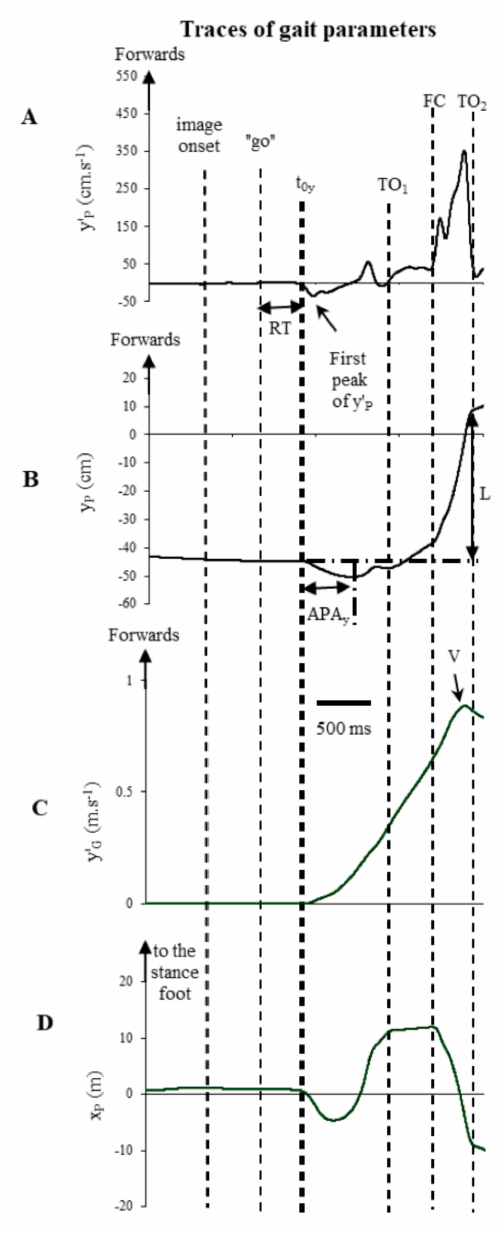
Figure 1. ( A ) anteroposterior velocity of CP (y’ p ); ( B ) anteroposterior displacement of CP (y p ); ( C ) anteroposterior velocity of CM (y (cid:48) G ); ( D ) mediolateral displacement of CP (x P ); one trail, one subject, during exposure of a pleasant image of the short condition. From top to bottom, the horizontal arrows correspond to the duration of anticipatory postural adjustments on the anteroposterior (APA y ) and the vertical arrow to the first step length (L). TO 1 is the time of foot contact of the stepping limb and TO 2 is the time of toe off of the stance